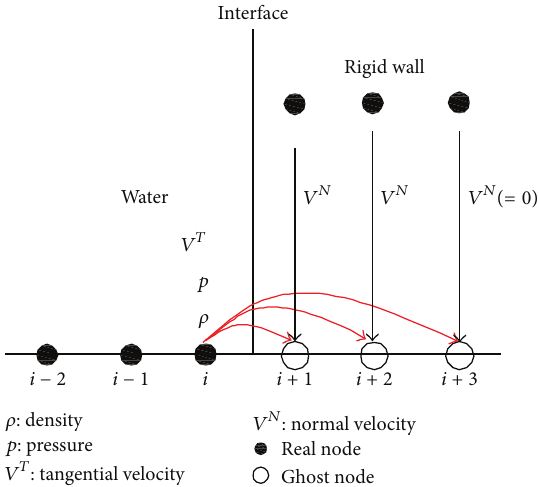
Figure 2: Illustrations for multidimensional GFM-based algorithm.